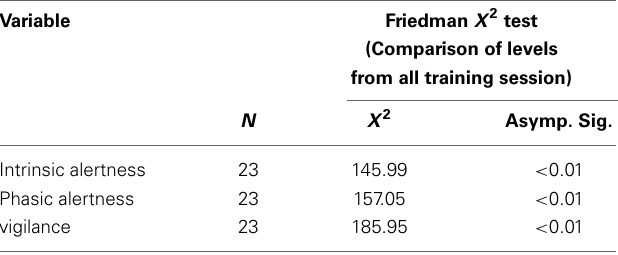
Table 5 | Training progress: cognitive training.